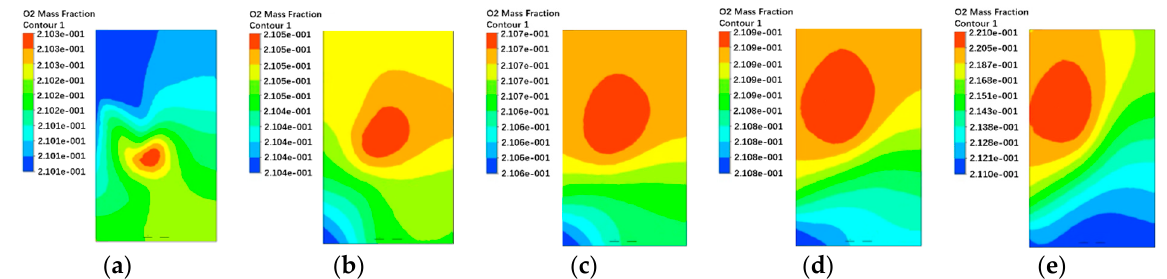
Figure 7. Oxygen mass fraction distribution of the single oxygen supply vent under un-air-conditioned conditions. ( a ) 5 s, ( b ) 20 s, ( c ) 60 s, ( d ) 90 s, ( e ) 120 s.